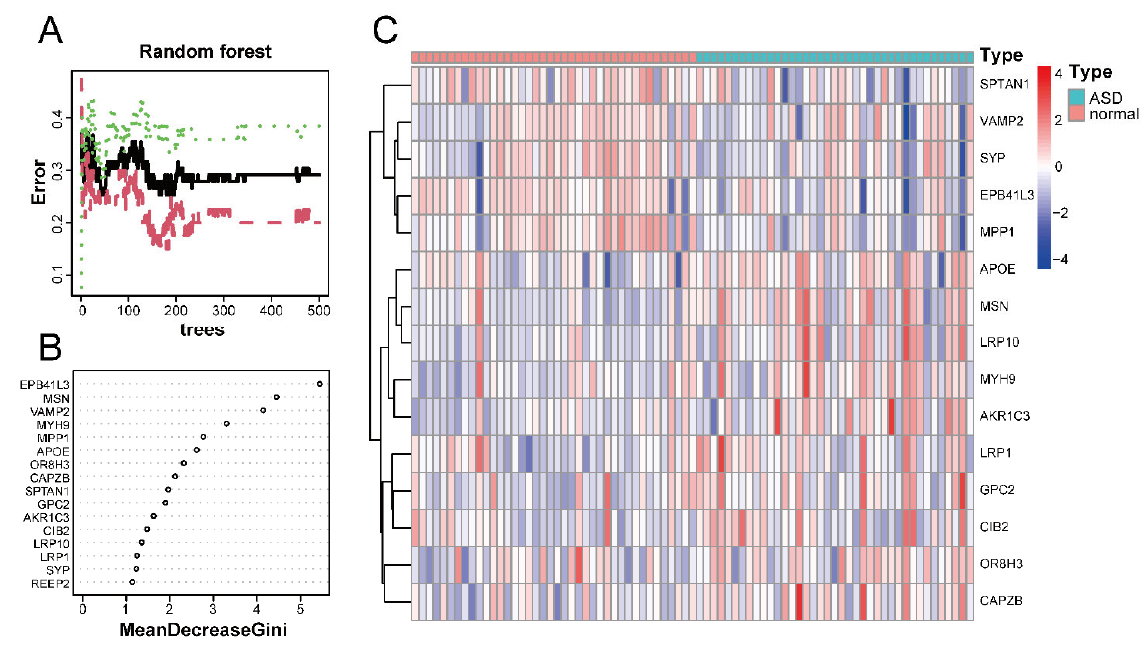
Figure 6. Screening of disease-characteristic genes by using a random forest classifier. ( A ) The relationship between the number of decision trees and the error rate. The x -axis and y -axis represent the number of decision trees and the error rate, respectively. The green color represents the error in the control group, the red color represents the error in the experimental group, and the black color represents the error in all samples. The error rate is lowest when the number of decision trees is 43. ( B ) Feature importance was measured using the Gini coefficient method. The x - and y -axes represent the genetic variable and the importance index, respectively. ( C ) Heatmap of 15 disease-characteristic genes obtained by random forest analysis. Red indicates the upregulated genes, and blue indicates the downregulated genes.